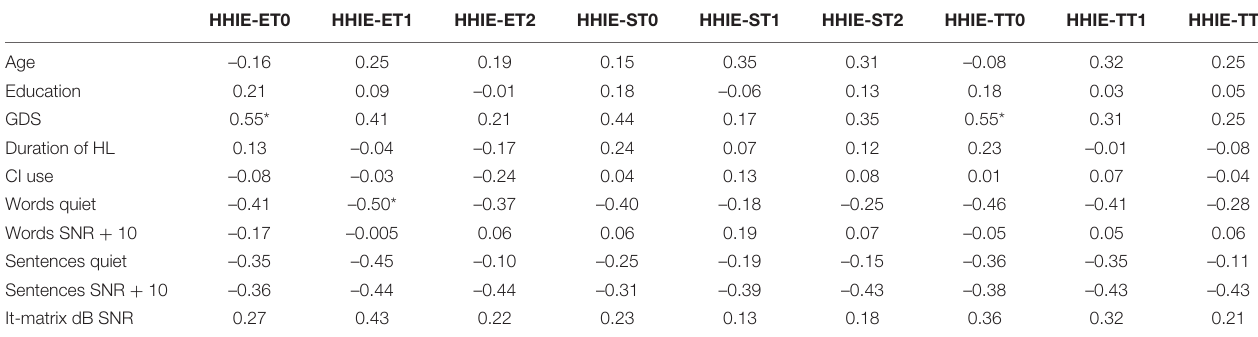
FIGURE 2 | Box plot representing scores obtained for the Speech, Spatial, and Quality (SSQ) questionnaire. Spe, Speech; Spa, Spatial; Q, Quality sections. White bars represent the total scores (SSQ_T), calculated as the sum of all sections. Scores were reported for each follow-up which were, respectively: Pre-Intervention (T0), 1-month (T1) and 6-month (T2). ∗ p ≤ 0.005, ∗∗ p ≤ 0.001 with Bonferroni corrections. TABLE 6 | The correlation between Hearing Handicap Inventory for older adults (HHIE) and personal and audiological variables of the group ( N = 20). HHIE-ET0 HHIE-ET1 HHIE-ET2 HHIE-ST0